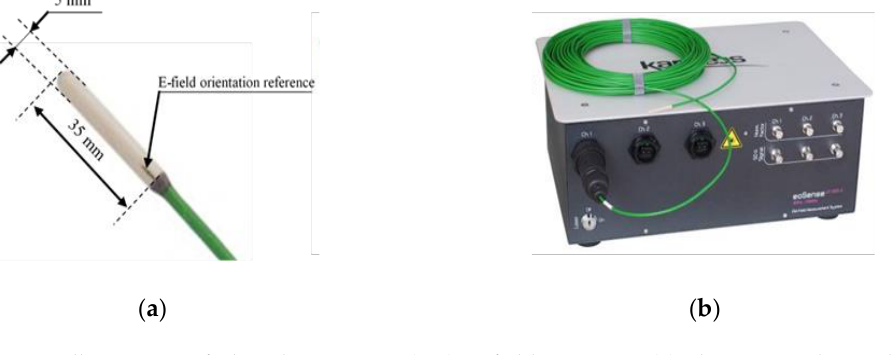
Figure 3. Illustration of the electro-optic (EO) E-field system: ( a ) the EO probe and ( b ) optoelectronic convertor.